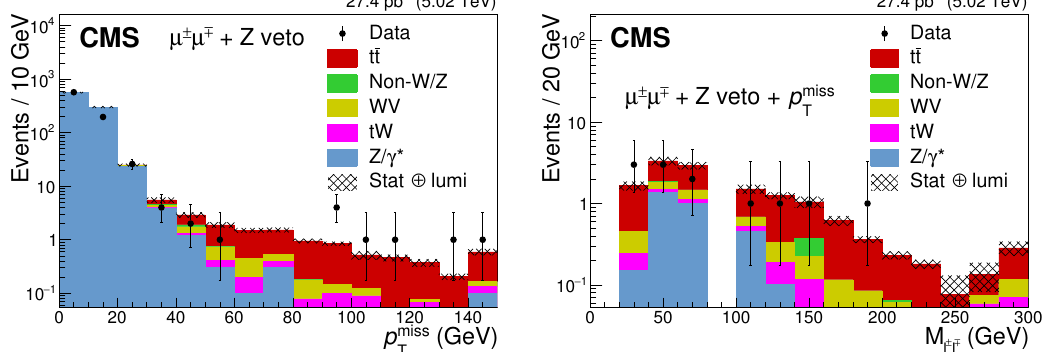
Figure 4 . Predicted and observed distributions of the (left) p miss teria and Z boson veto, and of the (right) invariant mass of the lepton pair after the p miss requirement in the (cid:22) (cid:6) (cid:22) (cid:7) channel. The cross-hatched band represents the statistical and integrated luminosity uncertainties in the expected signal and background yields added in quadrature. The vertical bars on the data points represent the statistical uncertainties. The last bin of the distribu- tions contains the over(cid:13)ow